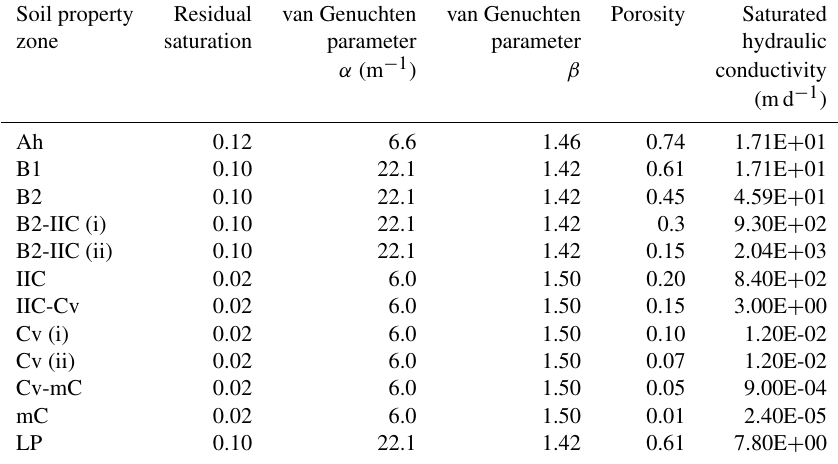
Table 1. Soil hydraulic parameters of the different soil property zones. Table adapted from Glaser et al. (2016). Soil